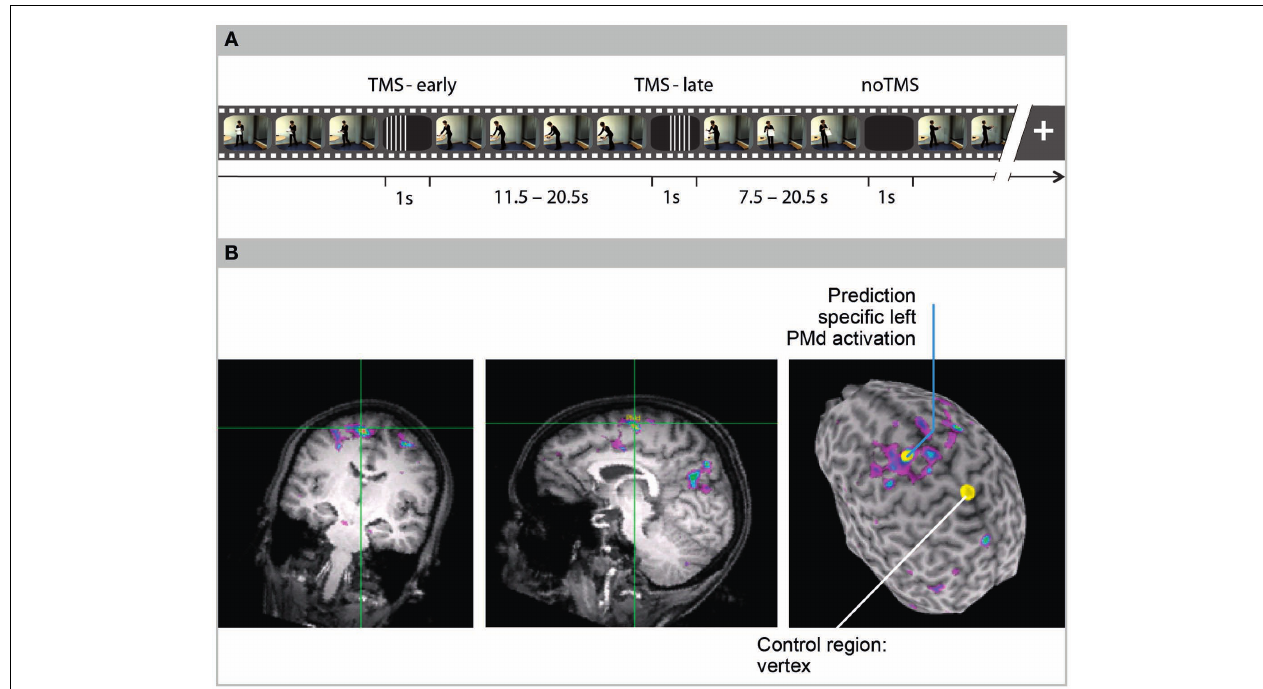
or 300ms after occluder-onset (TMS-late). In 50% of the trials (noTMS), performance under unstimulated conditions was assessed. Pulse trains included five single pulses at a frequency of 10Hz and lasted for 400ms.The interval between occlusions varied randomly between 7.5 and 20.5s. (B) fMRI-guided coil navigation. A functional brain scan of one exemplary participant is overlaid on the participant’s anatomical scan (coronal slice, sagittal slice, and 3D-rendered surface). In the 3D brain, yellow dots indicate the sites ofTMS application, left dorsal premotor cortex (PMd) as the region of interest, andVertex (VX) as the control region. For left PMd stimulation, the TMS coil was navigated to the local maximum obtained in an fMRI contrast between an action prediction task and an action memory